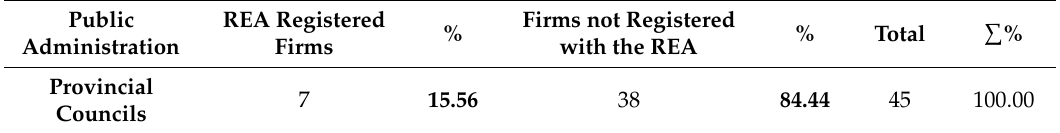
Table 5. Registrations on the REA by the Provincial Councils under study, values updated until 02 / 13 / 2017. Where: 100% = 45 Provincial Deputations in national territory. Source : Ministerio de